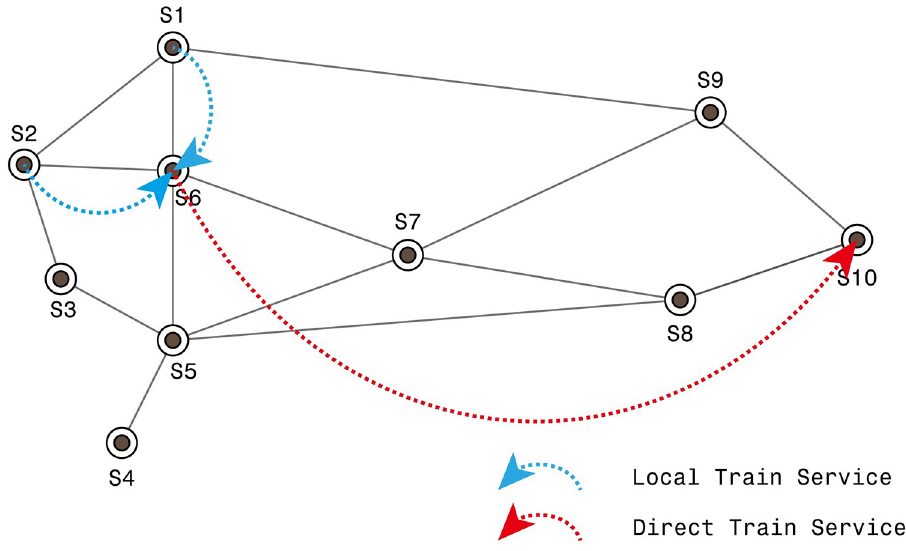
Fig 1. The connected service strategy of rail freight